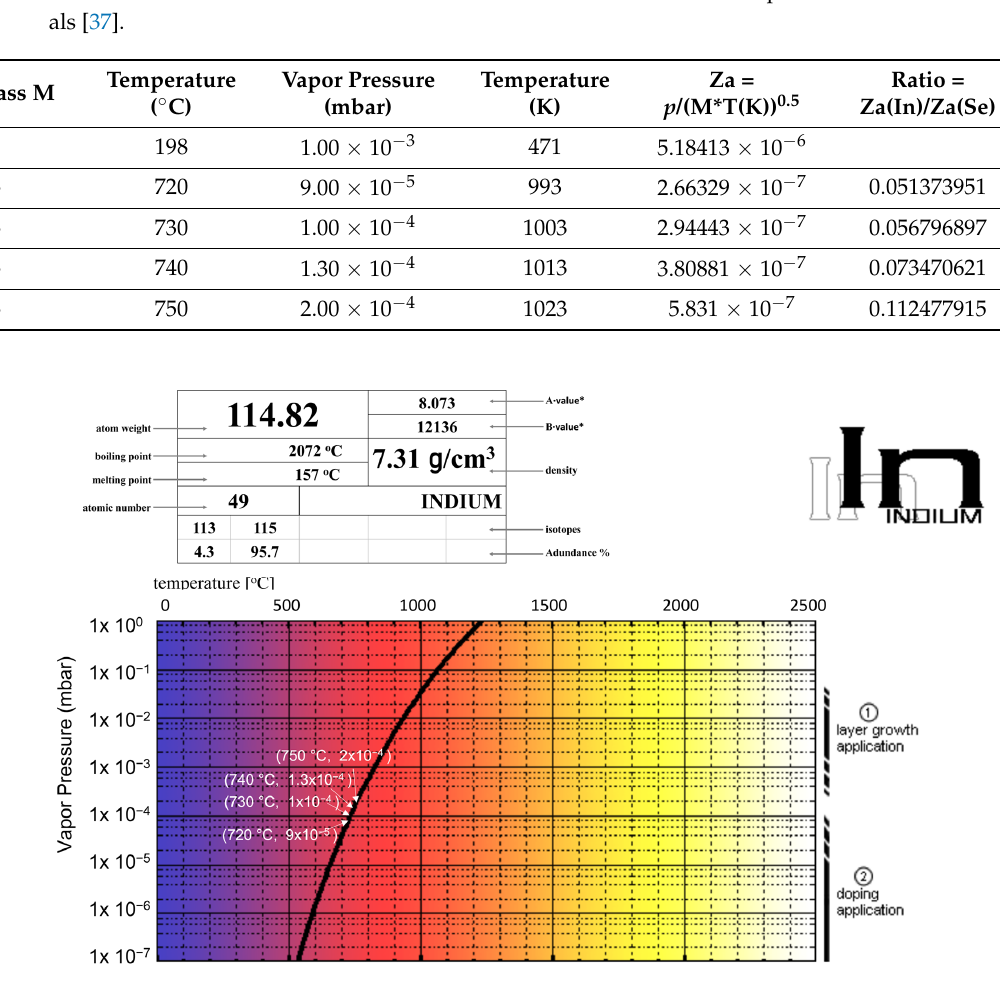
Figure A1. The temperature dependent vapor pressure of In.